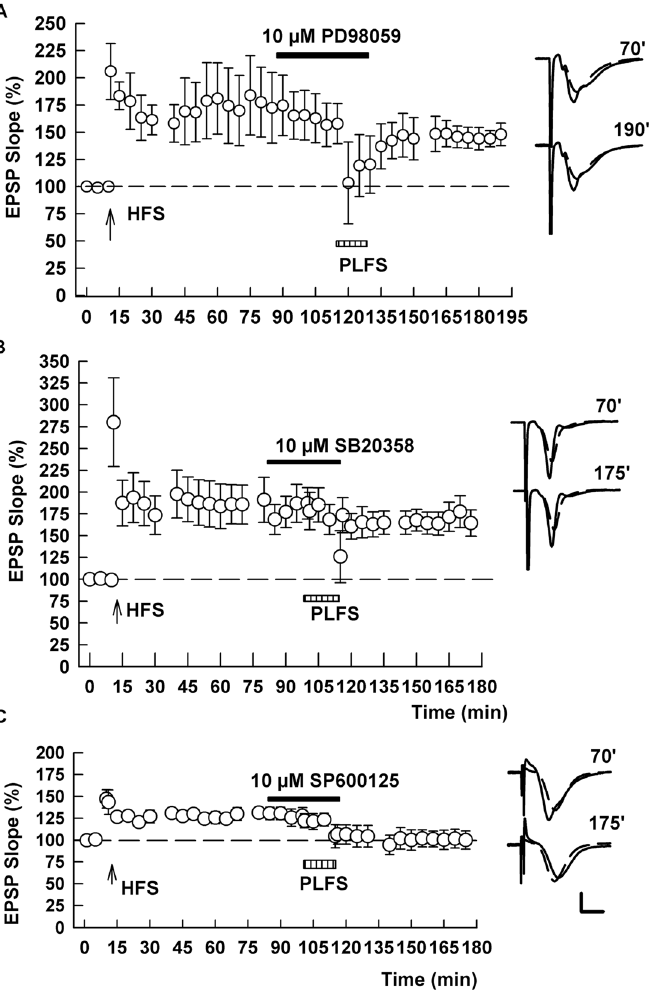
Fig 6. The MAP kinases ERK 1/2 and p38 contribute to TA-induced LTP-D. (A) In the presence of 10 μ M PD98059 (black bar), a MEK inhibitor that blocks signaling in the ERK pathway, PLFS (hatched bar) failed to induce LTP-D. HFS of the SC pathway was administered at the arrow. (B) Similarly, administration of 10 μ M SB20358, a p38 MAPK inhibitor, also blocked TA-induced LTP-D. (C) In contrast, 10 μ M SP600125, an inhibitor of the JNK pathway, did not prevent PLFS-induced LTP-D. Traces show representative EPSPs at the times indicated. Calibration: 1 mV, 5 ms.